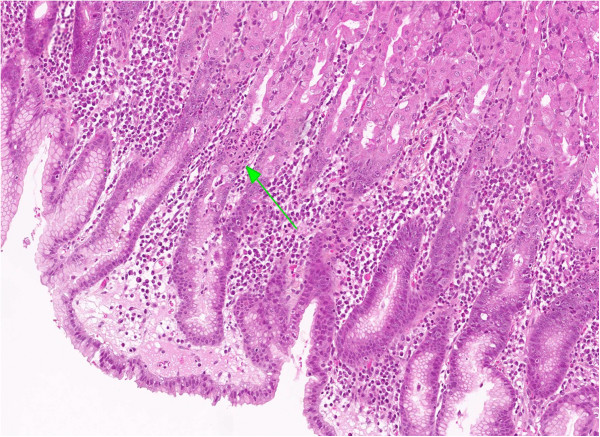
Histological section of H. pylori induced non-atrophic chronic gastritis. The arrow points out an area of active inflammation with characteristic granulocytic infiltration in the crypt epithelium.